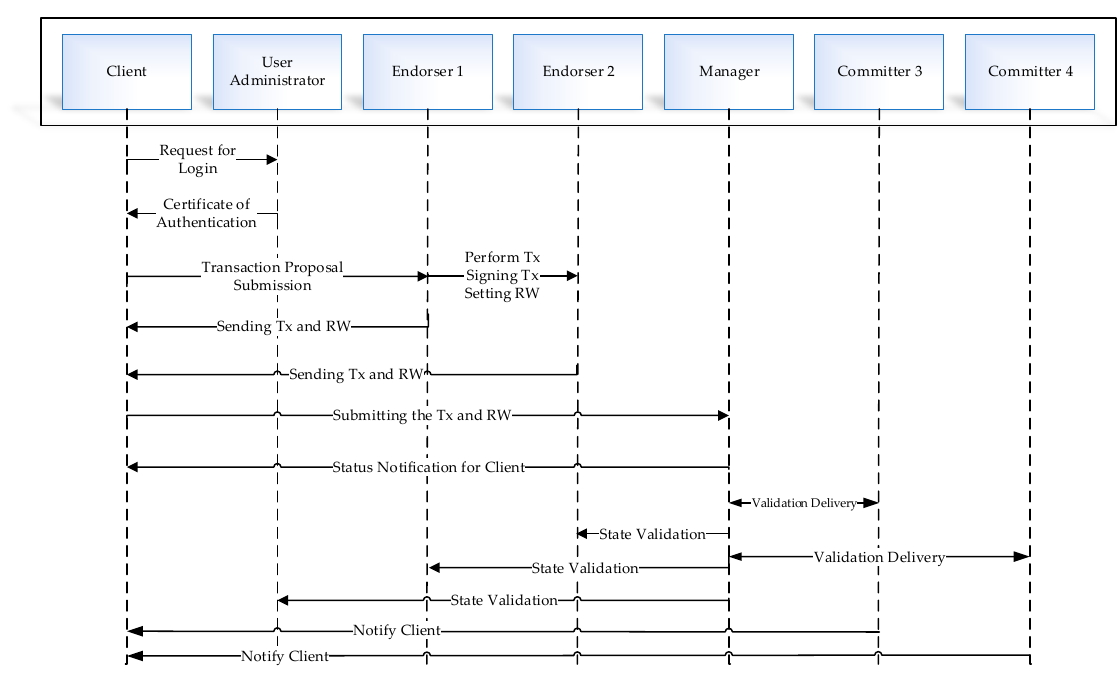
Figure 6. Procedure of transaction execution based on blockchain